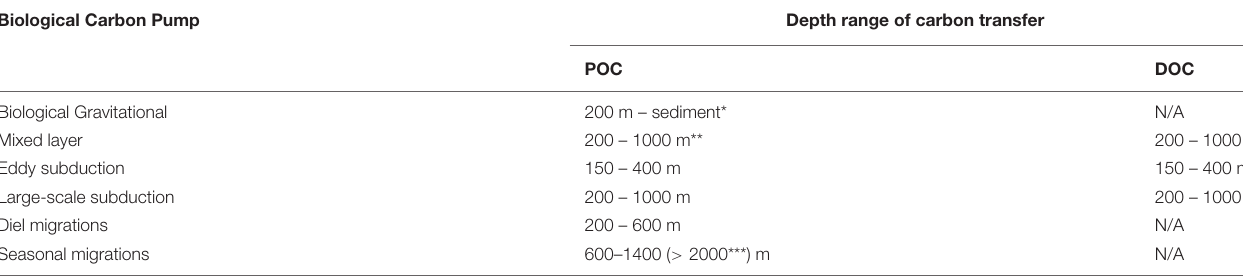
TABLE 2 | Range of depths generally reached by the downward transfer of POC and DOC by the six BCPs. Biological Carbon